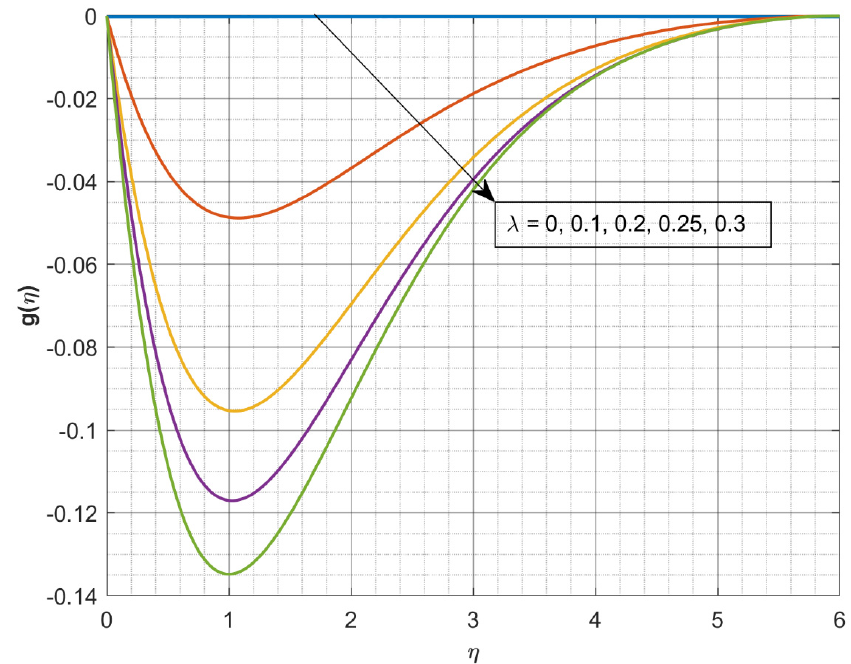
Figure 2. Influence of 𝜆 on 𝑔(𝜂) .